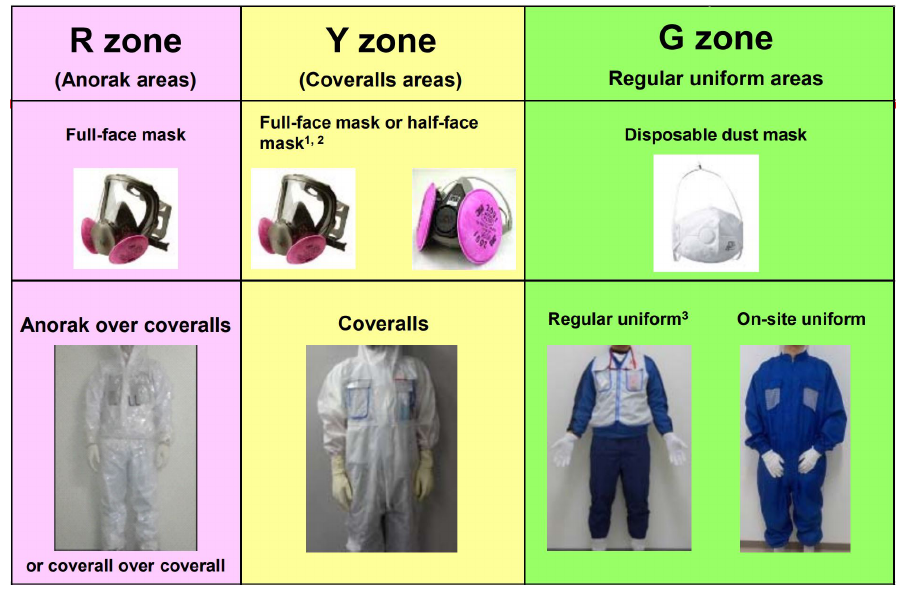
Figure 1. Each zone of the Fukushima Daiichi NPS site has different Personal Protective Equipment (PPE) requirements that should be adhered